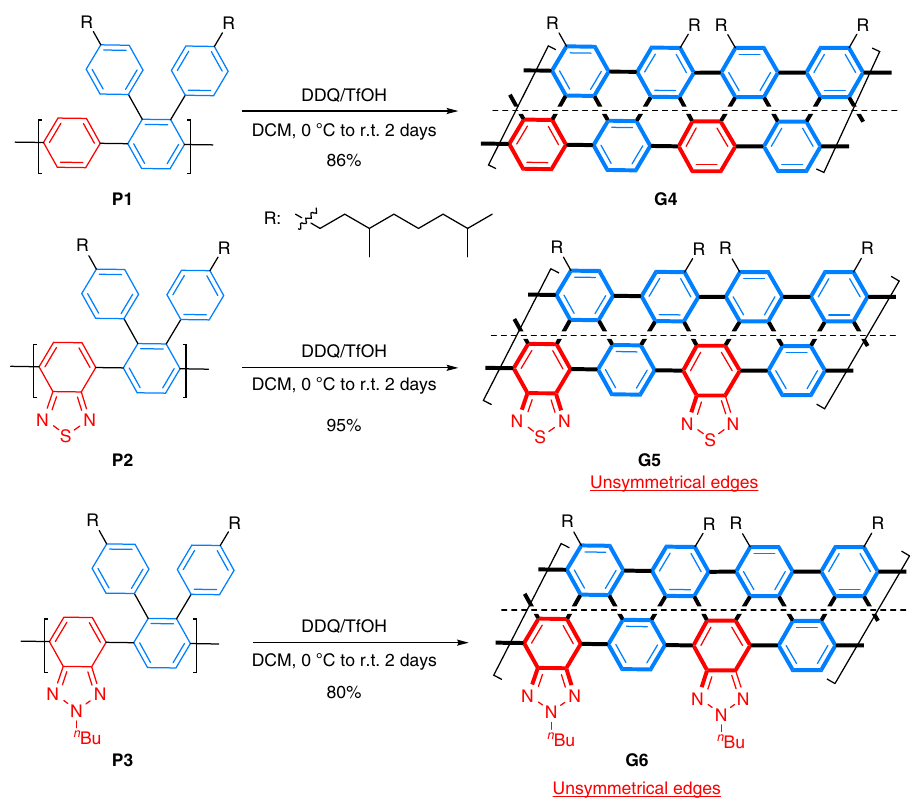
Fig. 3 Synthesis of graphene nanoribbons. Syntheses of N = 6 aGNR and its edge-functionalized